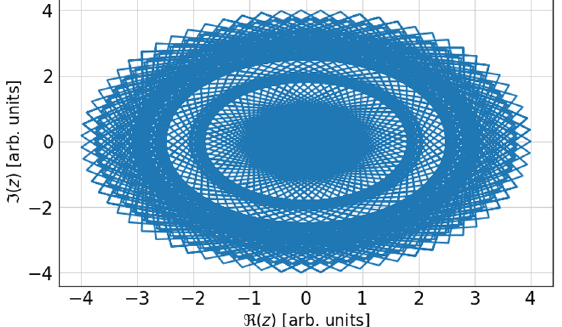
FIG. 3. The projection of the signal used in the numerical simulations, on the complex plane. The oscillations consist of the superposition of four frequencies, with a frequency-to-frequency shift of Δ Q ¼ 0 . 05